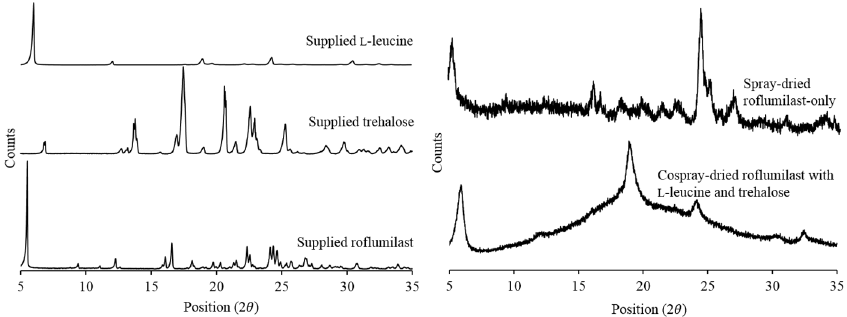
Figure 2. X ‐ ray diffractograms of supplied and spray ‐ dried powders. Figure 2. X-ray diffractograms of supplied and spray-dried